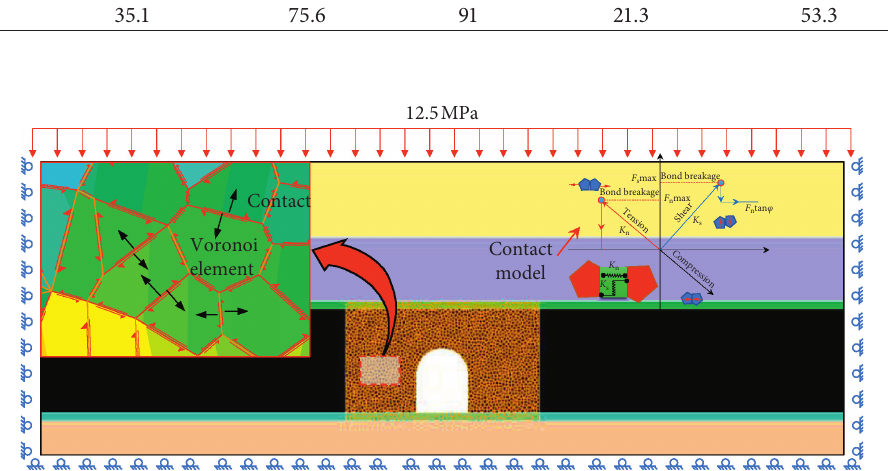
Figure 7: Numerical